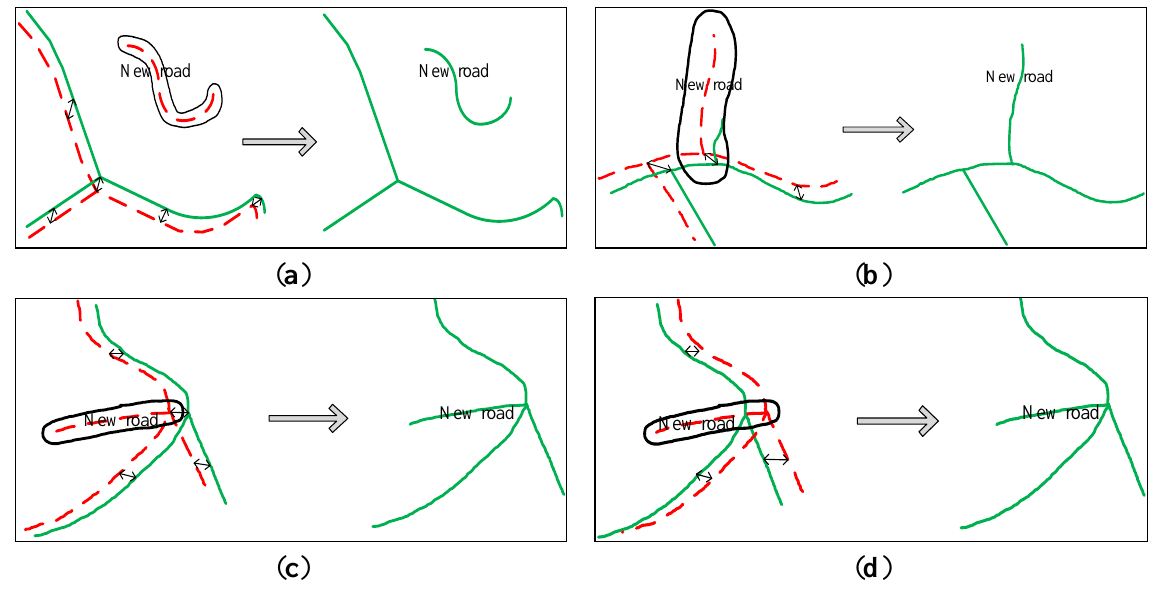
Figure 5. Scenarios of adding OSM (new) roads (red) into reference roads (green). ( a ) Isolated new road; ( b ) Removing insignificant reference road; ( c ) New road undershooting; ( d ) New road